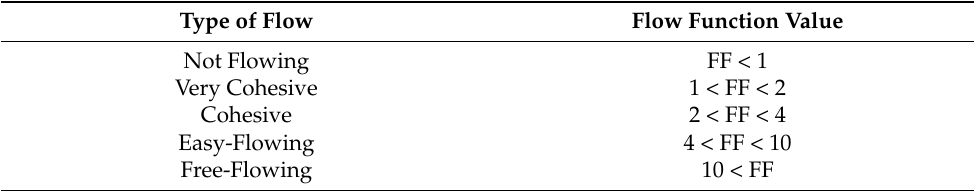
Table 1. Classification of particulate flowability based on flow function .